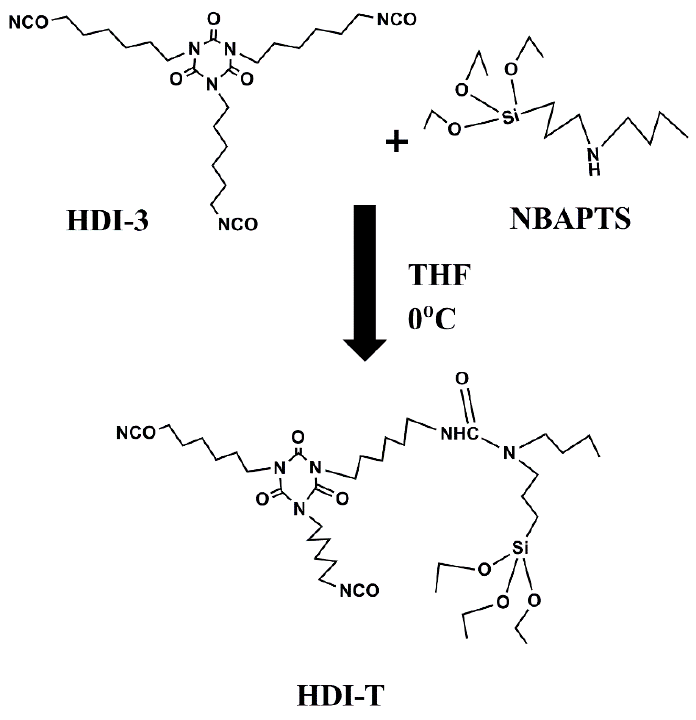
Figure 3. Preparation of HDI-T.